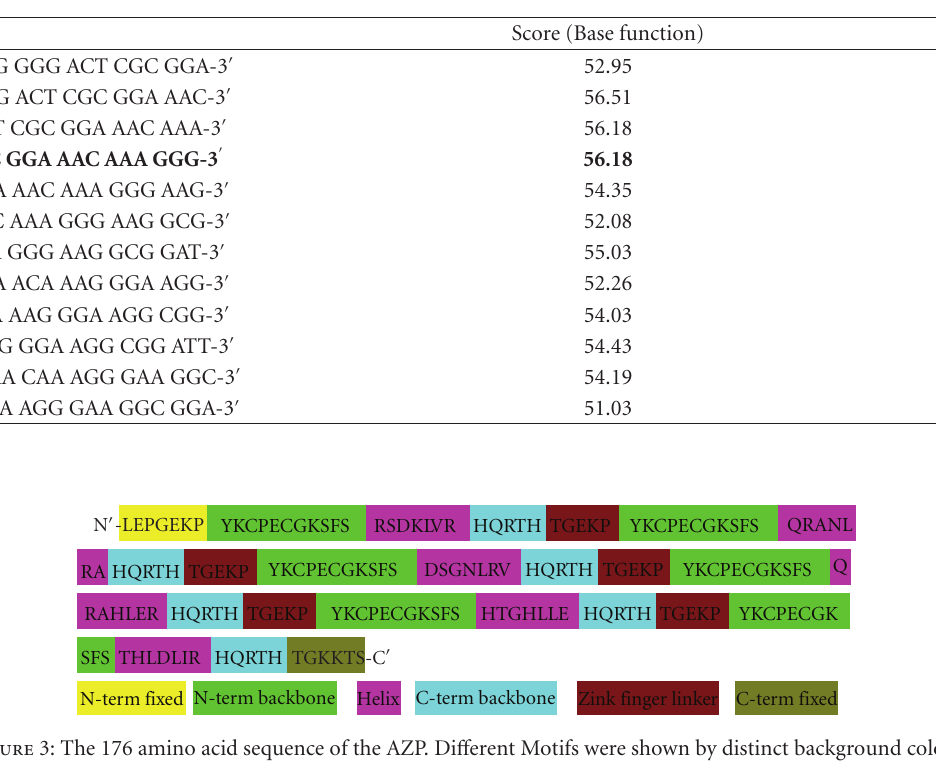
showed the conformation of the six zinc finger motifs. The modeling was based on the template 2i13A (a stable